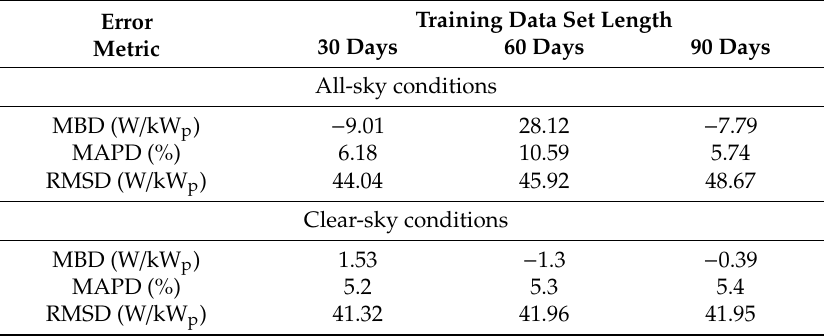
Table 5. Accuracy results of the digital twins created for 52 randomly chosen days in the year 2017. Six di ff erent training data sets including all-sky and clear sky-conditions with lengths of 30, 60, and 90